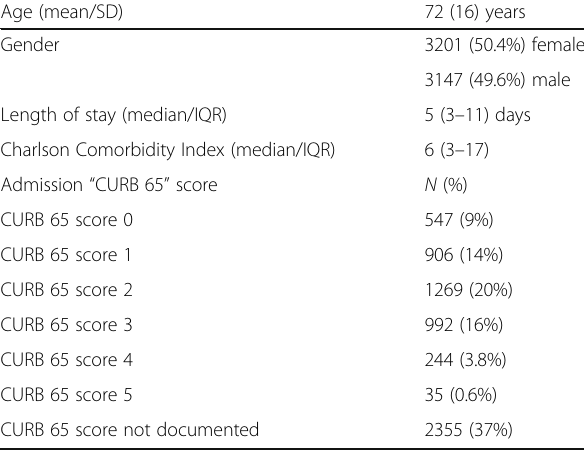
of human immunodeficiency virus (HIV) or acquired im- mune deficiency syndrome (AIDS) in the cohort. Table 2 Table 1 Demographics of the study